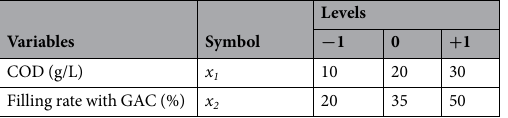
Table 4. Experimental range and levels for independent